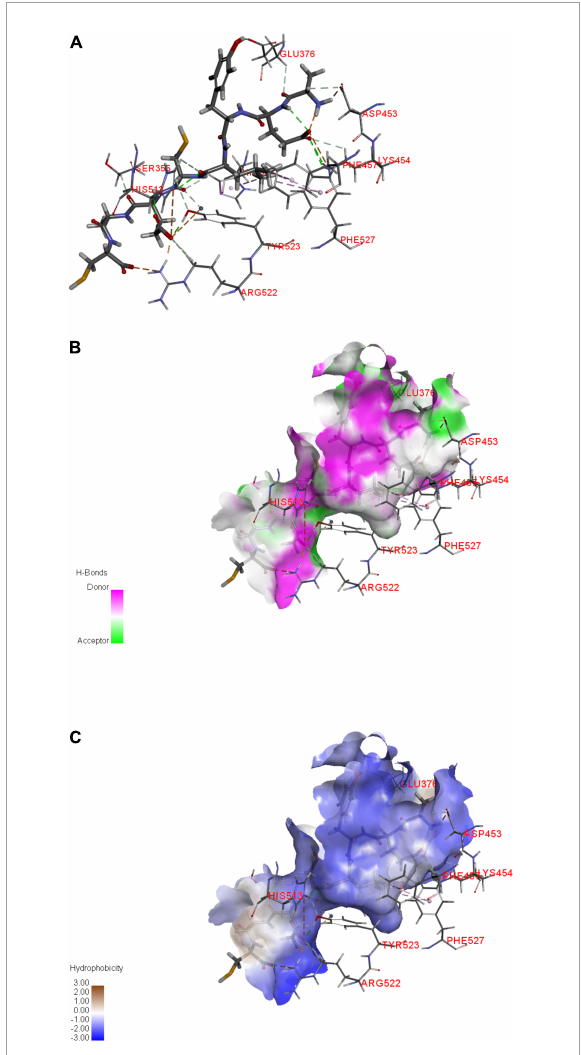
FIGURE5 Molecular docking simulations of AEYLCEAC against ACE (PDB: 4CA5). (A–C) Represent the active sites, hydrogen bonding, and hydrophobic interactions between AEYLCEAC and ACE, respectively.